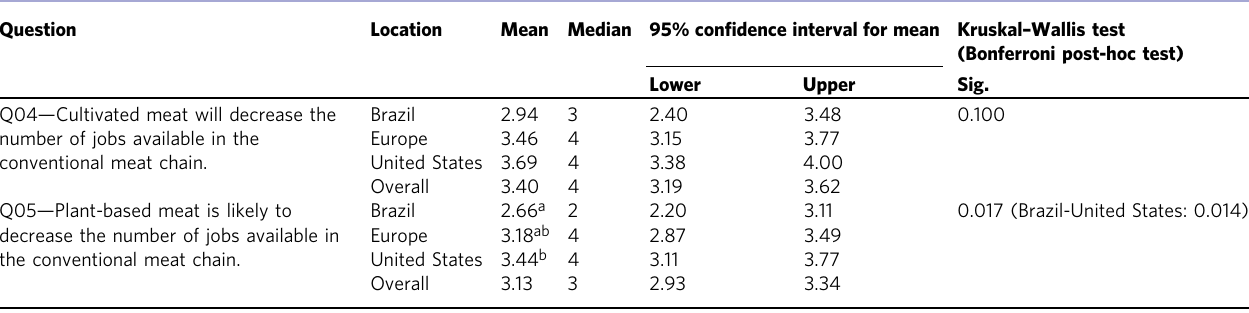
Table 4 Responses to questions regarding the impact on cultivated meat and plant-based meat on the number of jobs in the conventional meat industry in Brazil ( N = 35), Europe ( N = 56) and the United States ( N = 45) using Likert scale from 1 (strongly disagree) to 5 (strongly agree), according to questionnaires applied from August to October 2021.